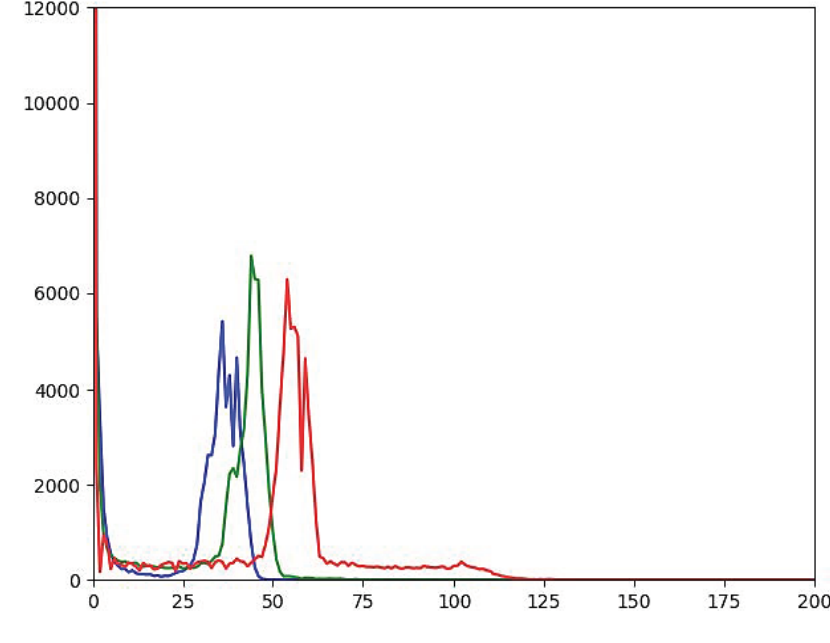
Figure 26. Histogram of the RGB graph for the image (see Figure